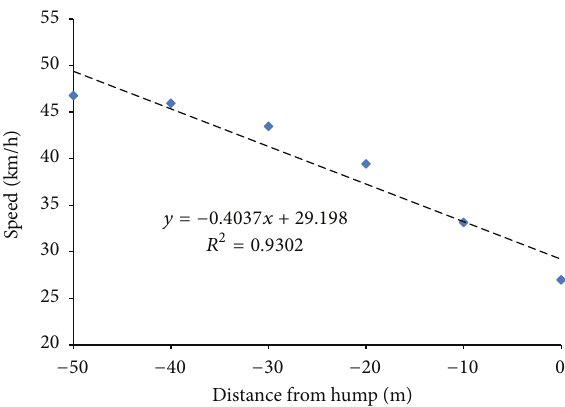
Figure 4: Mean speed profile at speed table riding.